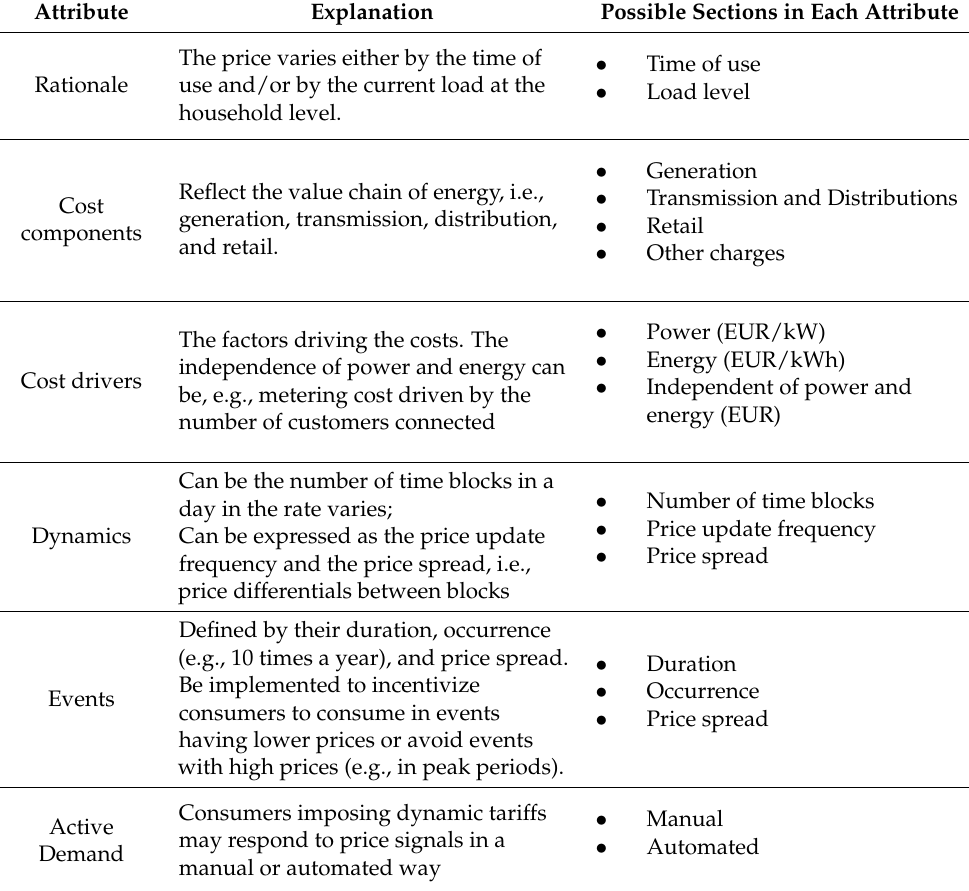
Table 2. Six attributes of dynamic tariffs (modified from